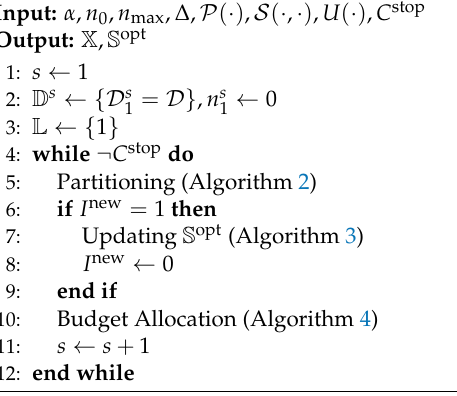
Algorithm 1 PAR-